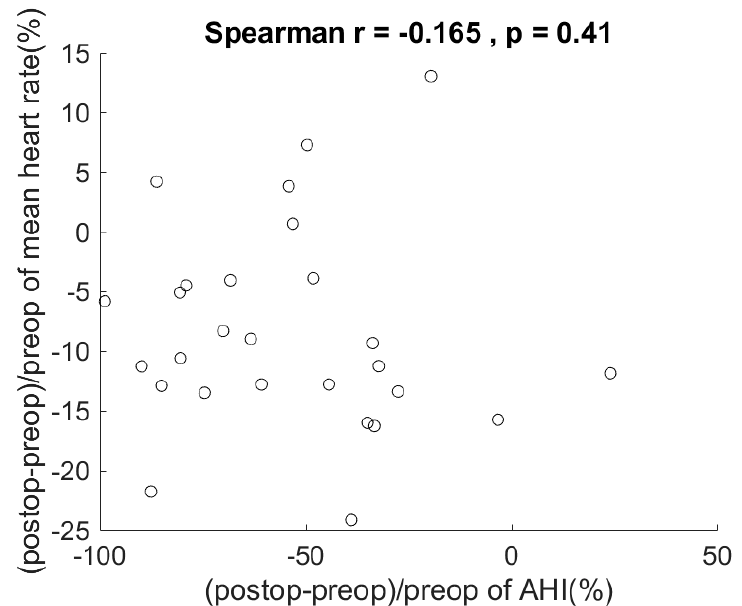
Figure 4. Scatter plot and correlation of change in AHI (defined here as (postoperative–preoperative)/preoperative AHI) vs. change in mean heart rate (defined here as (postoperative–preoperative)/preoperative mean heart rate). This shows that the change in mean heart rate was not related to the change in AHI.